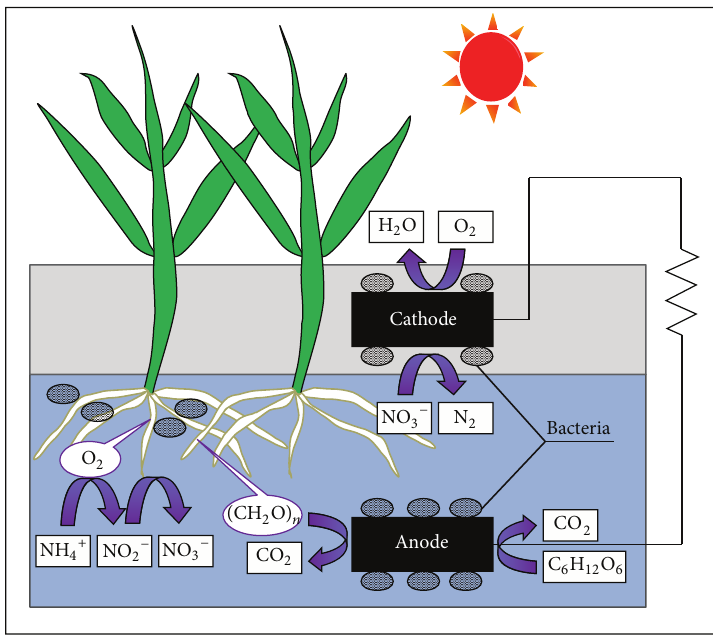
Figure 8: The principal reactions for the overall process of the CW-MFC. (1) Plant roots secrete O 2 and ( CH 2 O ) 𝑛 . (2) Electrons are produced at the anode from the anaerobic degradation of ( CH 2 O ) 𝑛 and C 6 H 12 O 6 . (3) NH 4+ was converted to NO 3− by Nitrifying bacterias in the rhizosphere. (4) O 2 and NO 3− were electron acceptors at the